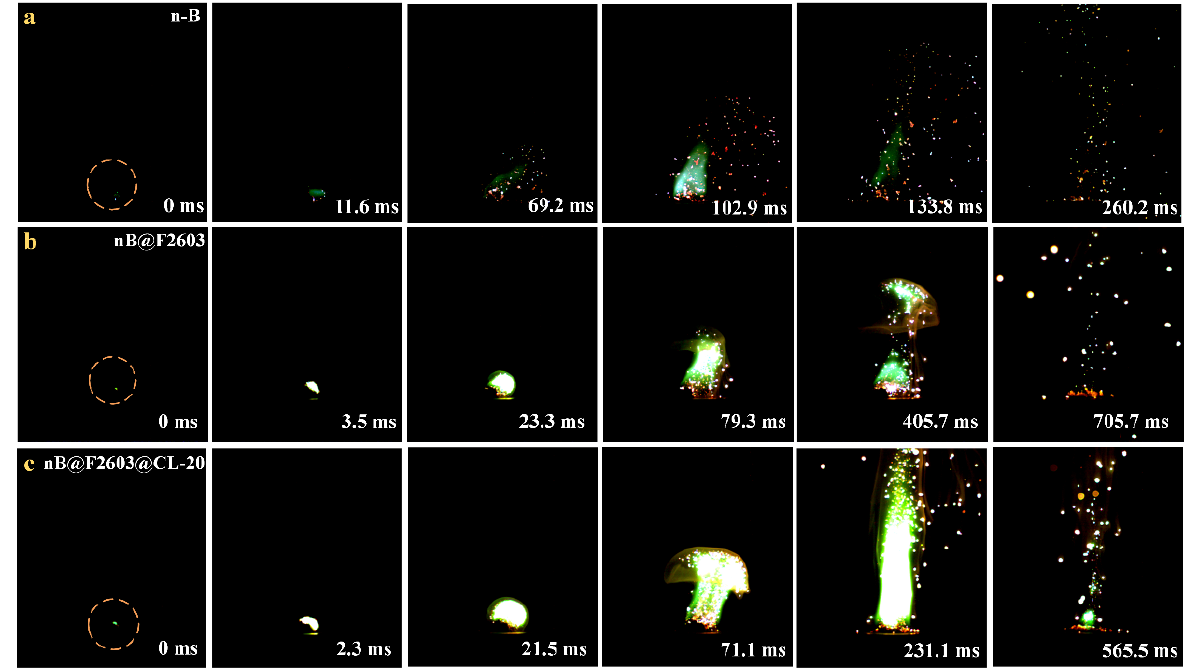
Figure 10. Ignition and combustion of ( a ) n-B, ( b ) nB@F2603 microspheres, and ( c ) nB@F2603@CL-20 microspheres in environment.